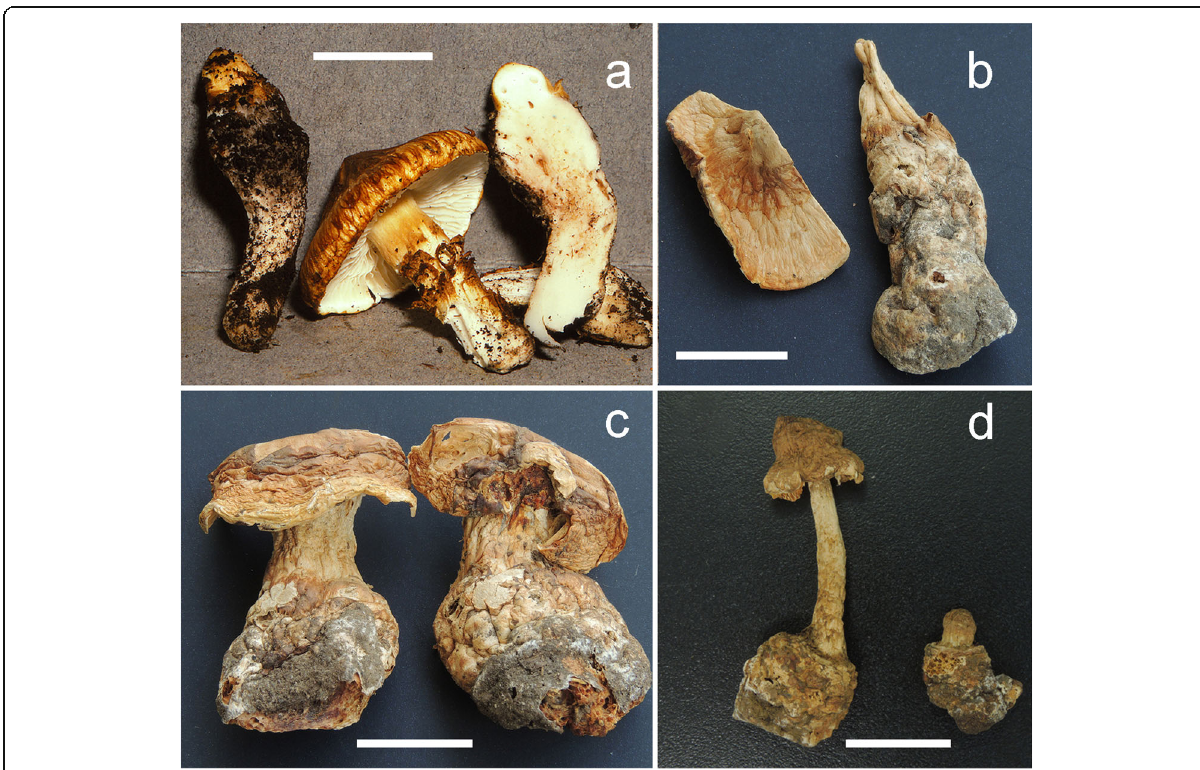
Fig. 13 Specimens of “ Squamanita umbonata ” included in this study. a Fresh basidiomes of R. E. Halling 7691 with cylindrical to clavate fusiform mycocecidium from Costa Rica. b C. Bas 3808 from USA with cylindrical mycocecidium. c H. E. Bigelow 17431 from USA with subglobose mycocecidium, a lump of clay is attached on the center of pileus of the specimen on the right, and the apical part of volval remnants on mycocecidium can be observed between clay and pileus under anatomical lens. d HKAS107325A from Italy with subglobose mycocecidium. Bars a = 25 mm, b – d = 20